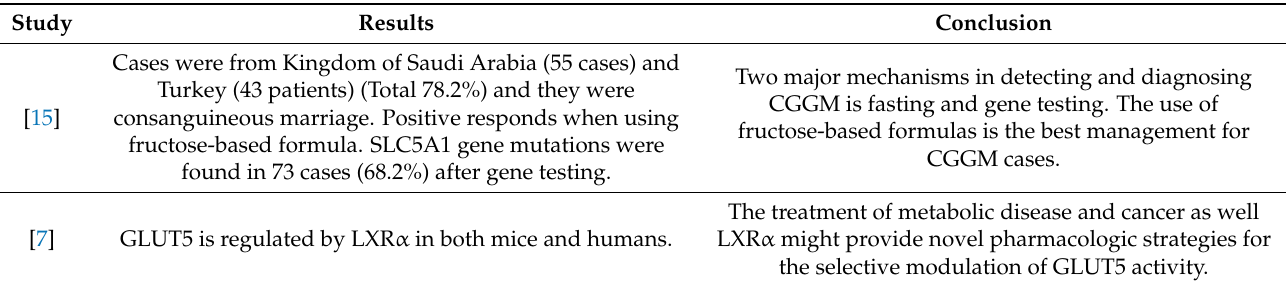
Table 1. A summary of all articles included in the review